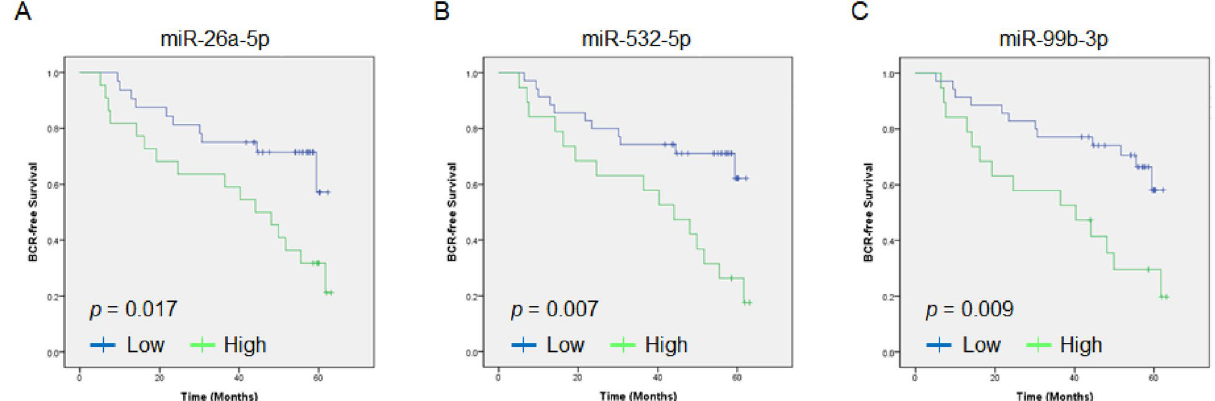
Figure 3. Comparison of BCR-free survival of the prostate cancer patients with exosomal miR-26a-5p ( A ), miR-532-5p ( B ), and miR-99b-3p ( C ). Patients with high miRNA expression showed significantly shorter BCR- free survival than those with low miRNA expression.